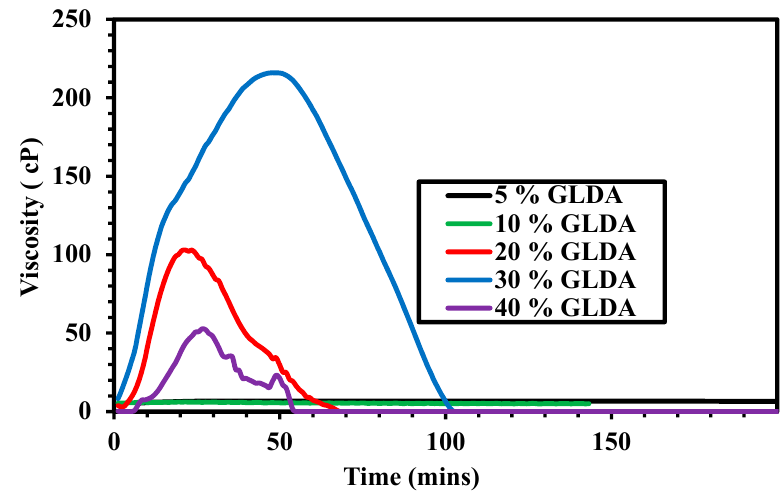
Figure 8. Apparent viscosity of AMPS polymer with a different concentration of GLDA at 300 °F (Shear rate = 511 s − 1 , P = 300 psi, pH = 12).